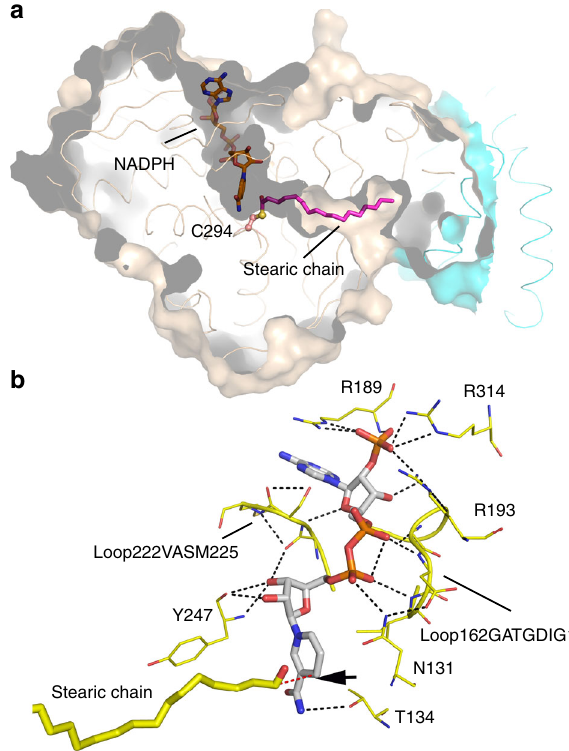
Fig. 3 AAR NADPH – ADO structure. a Surface representation of AAR NADPH – ADO structure. AAR and ADO are shown in wheat and cyan, respectively. NADPH and stearic chain (shown as stick) are accommodated in the L-shaped channel. The residue C294 is highlighted in stick-ball mode. b The interaction of NADPH with adjacent residues of AAR. Two loops of AAR sandwiching NADPH are shown in ribbon mode. NADPH and the stearic chain are colored white and yellow, respectively, for the carbon atoms and shown in sticks. Residues involved in the NADPH interactions are shown in lines. The hydrogen bonds are shown by black dashed lines. The C4 atom of NADPH (indicated by black arrow) is close to the stearoyl- C1 atom with a distance of 3.14 Å (red dashed line).